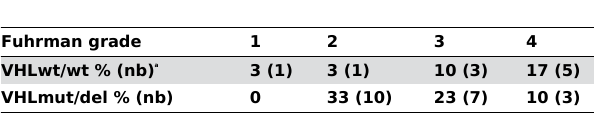
Table 1. Fuhrman grade and VHL status of the 30 clear cell renal cell carcinoma (ccRCC) specimens under